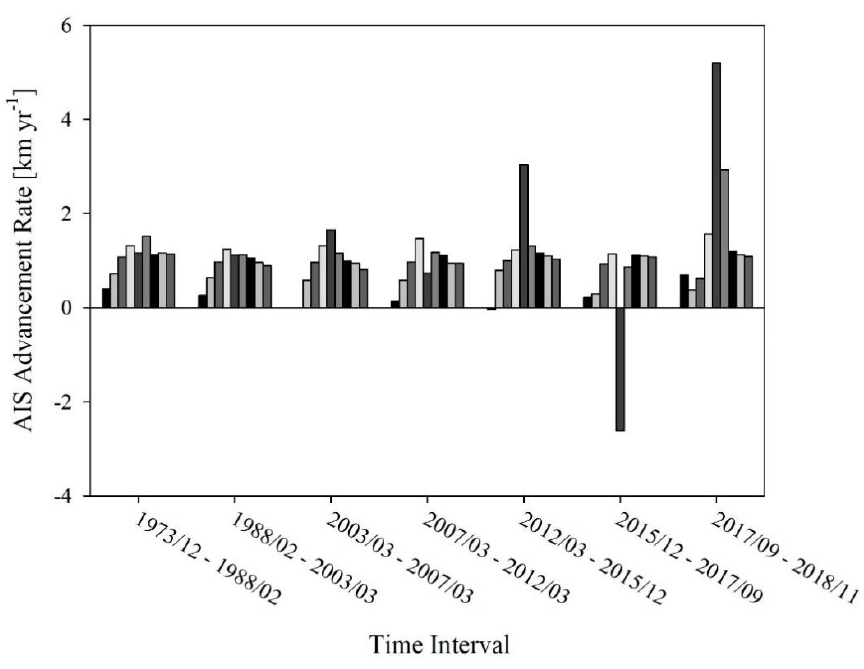
Figure 2. Advancement rate of the AIS along nine longitudinal flowlines during 1973–2018. The geographic locations of the flowlines are illustrated in Figure 1. The calving front retreat between 2015 and 2017 along flowline #5 reflects the loss of ice possibly due to some small calving event. Note that the bars from left to right in each histogram represent the flowlines from west to east (referred as flowlines #9 to #1) as shown in Figure 1.